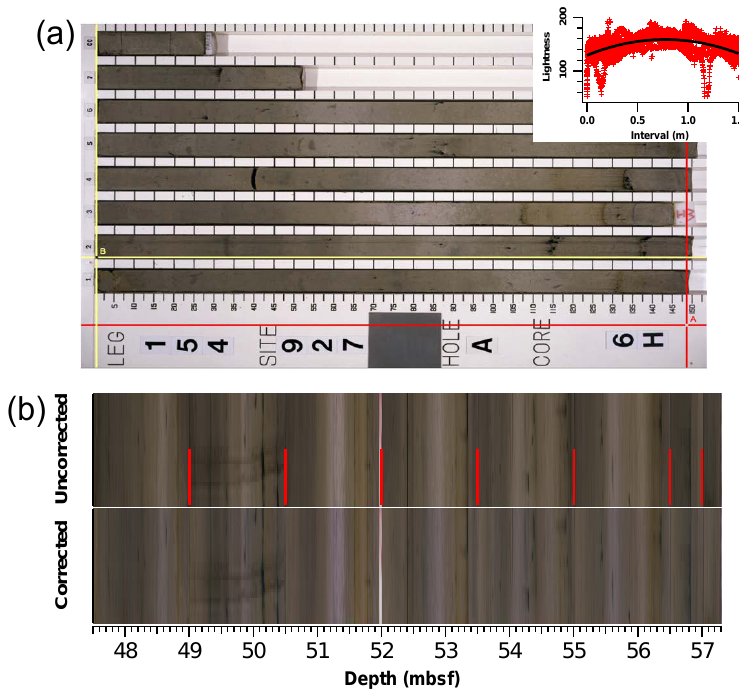
Figure 2. Creating a composite core image from a core table image. (a) Image loaded into IGOR. Red cursor moves horizontally to set bottom locations in pixels of each section. Yellow cursor moves horizontally and vertically to the lower left corner of each section before cutting. Inset – lengthwise lightness profiles for each of the cut sections and a best fit line used for the lighting correction. (b) Composite core image scaled to mb.s.f. Vertical red lines indicate section breaks. Lower image has been corrected for uneven lighting in the core box